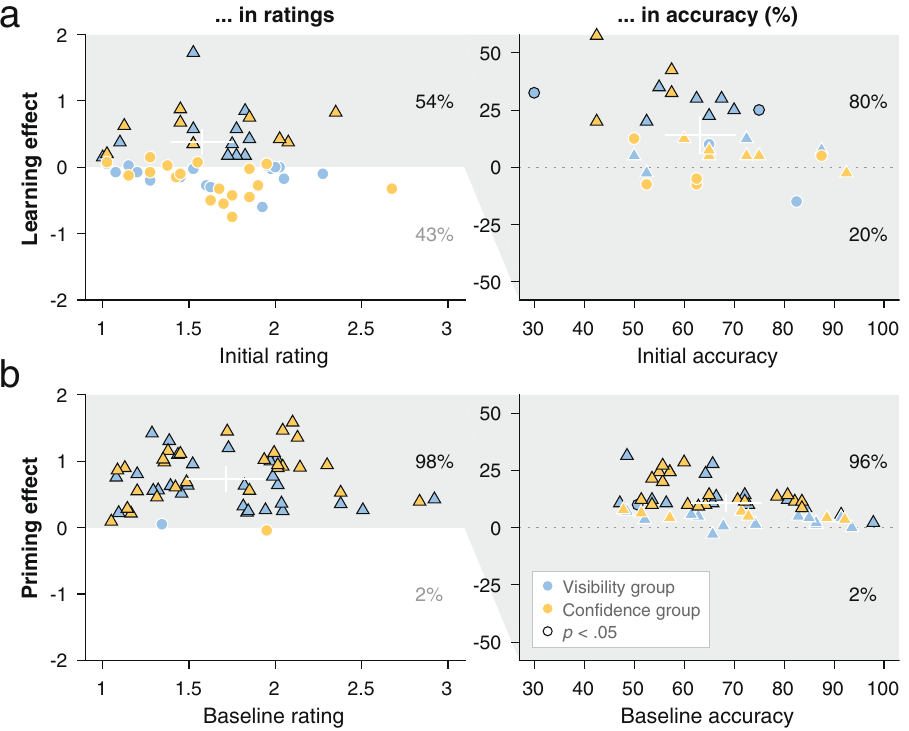
Figure 4. Distinct contributions of learning and priming to rapid perceptual enhancement in hard trials, as revealed by conditioning accuracy effects on positive rating effects. ( a ) Learning was positive in terms of ratings in 54% of participants (left), and only a subset of them showed a corresponding accuracy effect (right). ( b ) Priming was positive in terms of ratings in 98% of participants (left), and most of them showed a corresponding accuracy effect (right). Note that with the same data set the order of conditioning (testing accuracy effects based on positive rating effects) was the reverse of Fig. 3. Percentages represent the proportions of participants showing positive or negative effects. Each dot or triangle represents an individual participant (triangle denotes statistically significant rating effect at the individual level, p < 0.05, one-tailed); black contour denotes statistically significant effect at the individual level, p < 0.05 (white contour, non-significant effect); center of the white bar, mean of the individuals within the highlighted (gray) region; full length of the white bar, a standard